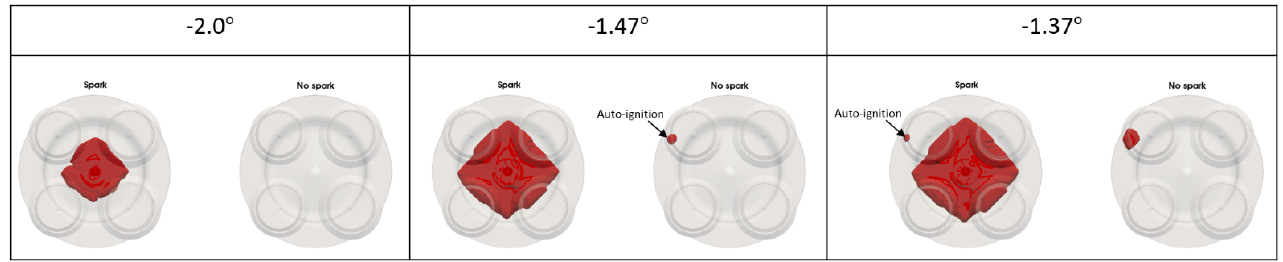
Figure 5. Effect of the spark plug on the predicted pressure and heat release rate traces for the base- line case. Figure 6. Comparison of temperature iso-surface (1600–3000 K) for spark vs. no-spark cases.